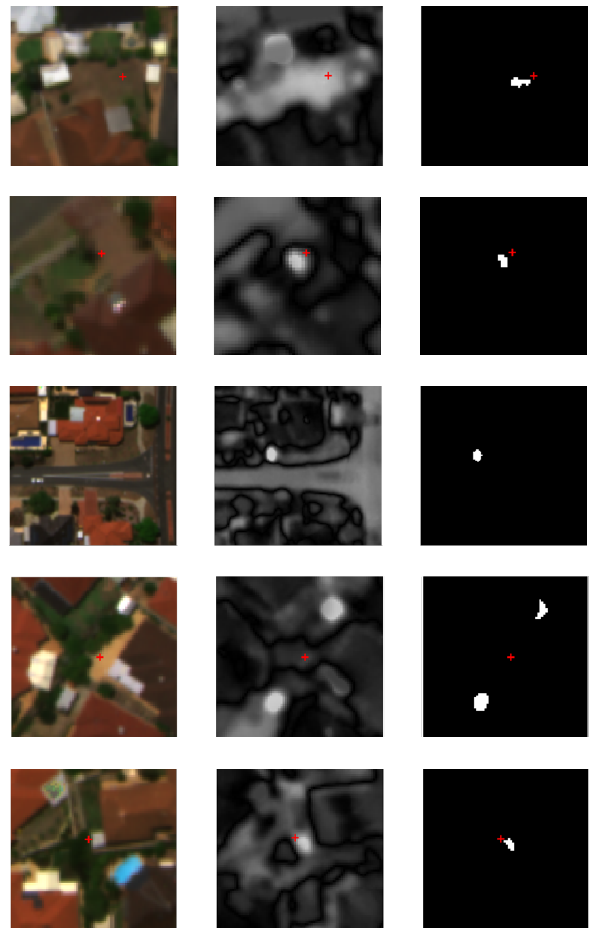
Figure 1. Examples of regions of interest: Orthophoto (left), mean-substracted difference image (middle), binary mask of regions of interest (right), labeled as anomaly (rows 1-3) and explainable (rows 4 and